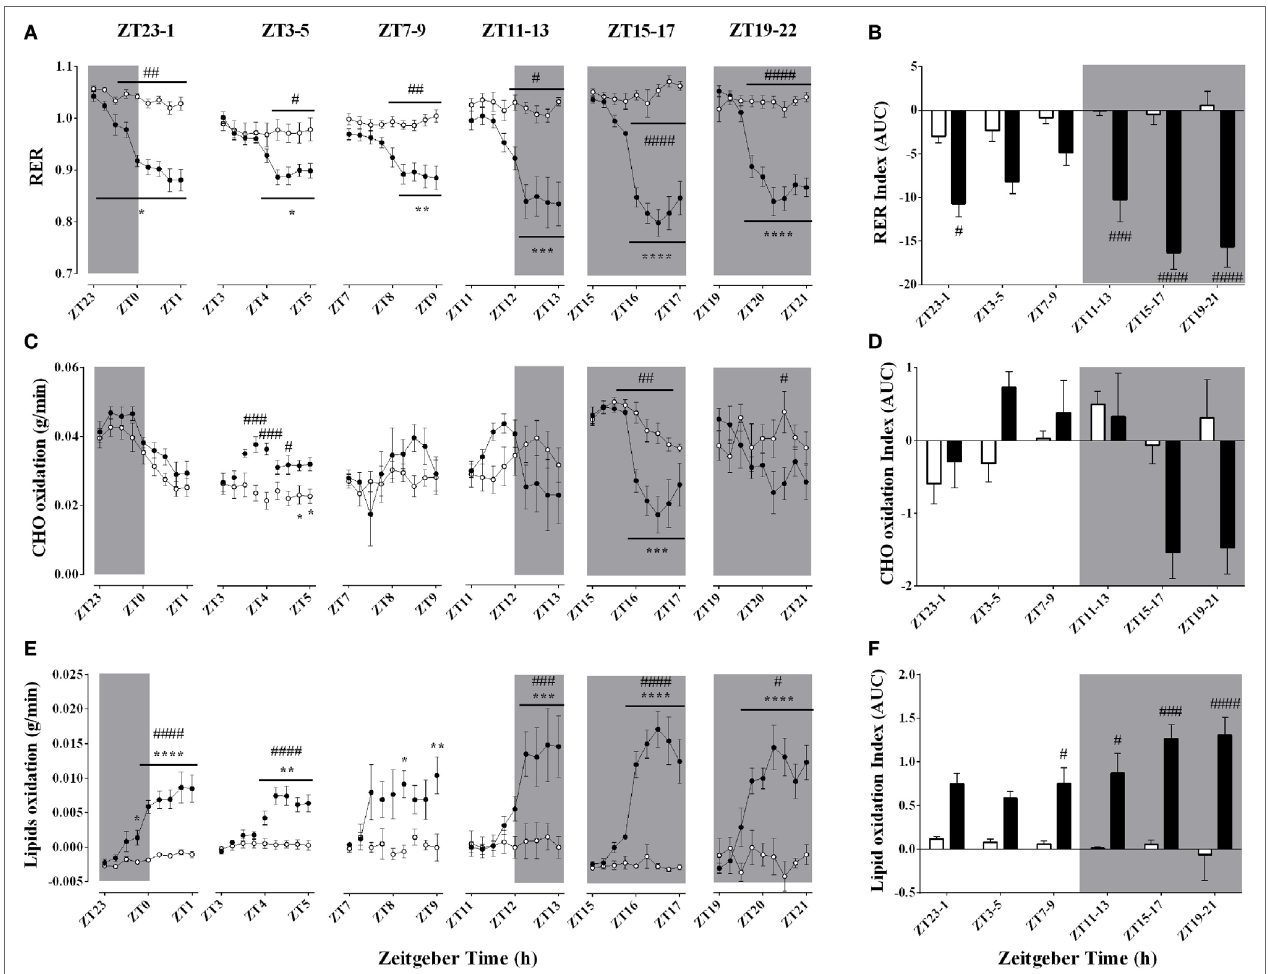
FigUre 5 | Effect of time­of­day on respiratory quotient (a,B) , carbohydrate (c,D) , and lipid oxidation (e,F) changes induced by environmental cooling. Results are presented as averages of 15 min bins during 2 h of environmental cooling (a,c,e) and area under the curve (AUC) (B,D,F) calculated as the net change from the basal levels before cold exposure. Light phase began at Zeitgeber Time 0 (ZT0) and dark phase (shaded areas) began on ZT12. Results are presented as mean ± SEM * indicates differences between the first and the other time­points within the control or the cold­exposed group, p < 0.05. # indicates differences between control and cold conditions, p < 0.05 . n =